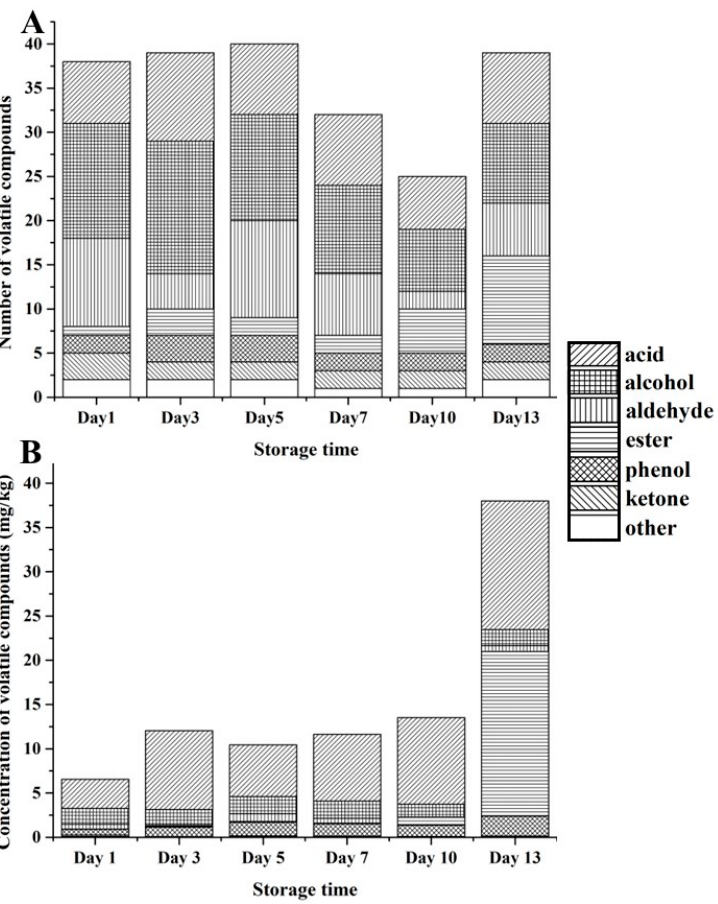
Figure 3. ( A ) Numbers and ( B ) concentrations of volatile compounds in the stinky tofu samples during storage. during